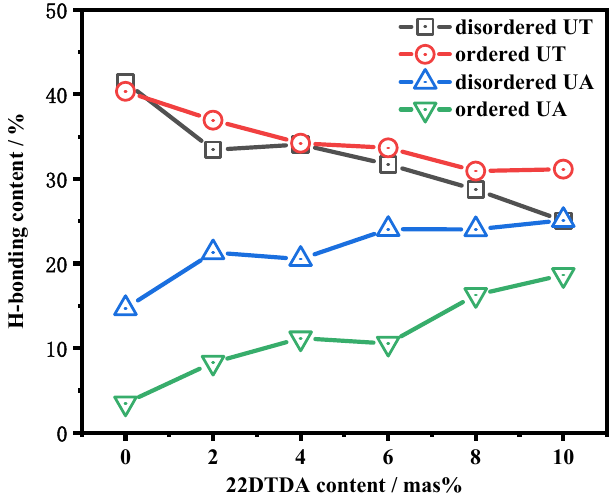
Figure 6. H-bonding ratio in the P22 films with the 22DTDA contents in the range of 2 to 10 mas%.